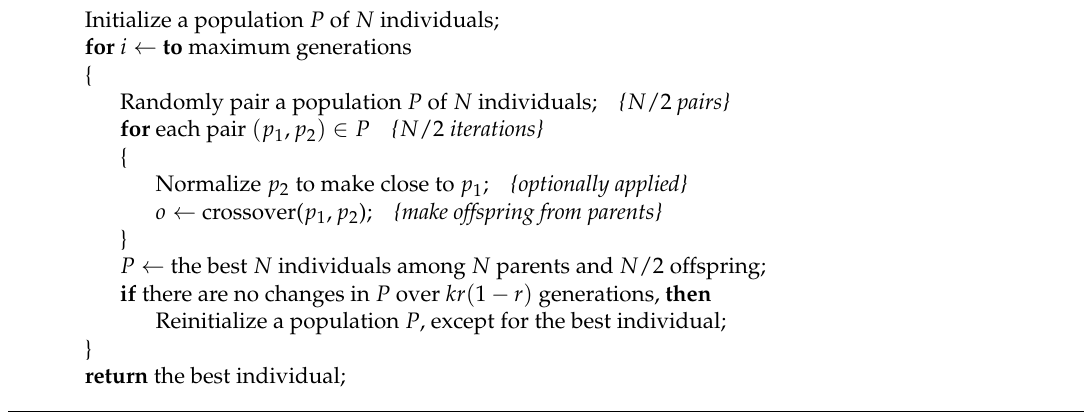
Figure 8. Pseudocode of our genetic